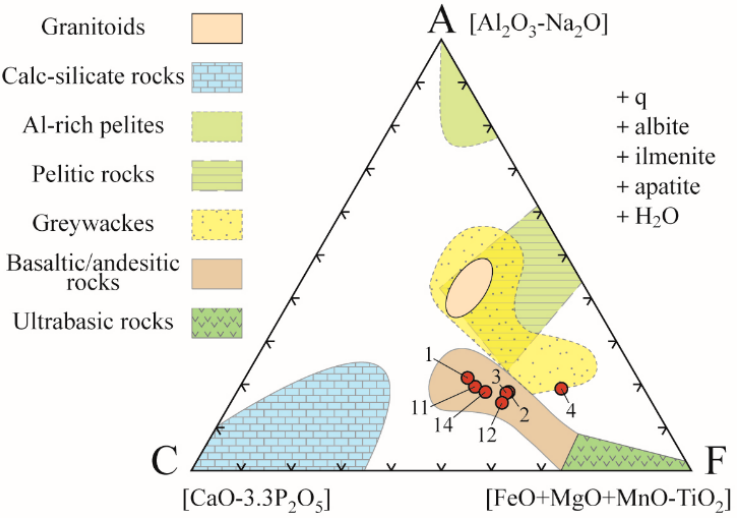
Figure 13. Chemical composition of the studied metabasite tectonites on the ACF diagram [96].